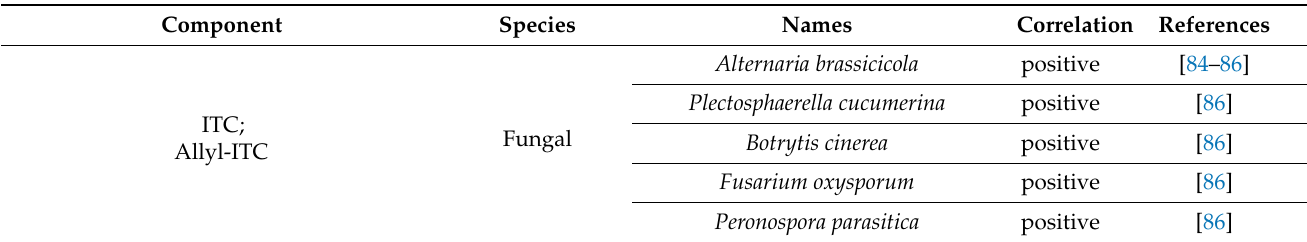
Table 1. Correlation of the GLS components and their metabolites in corresponding pathogen, pest, and insect resistance.